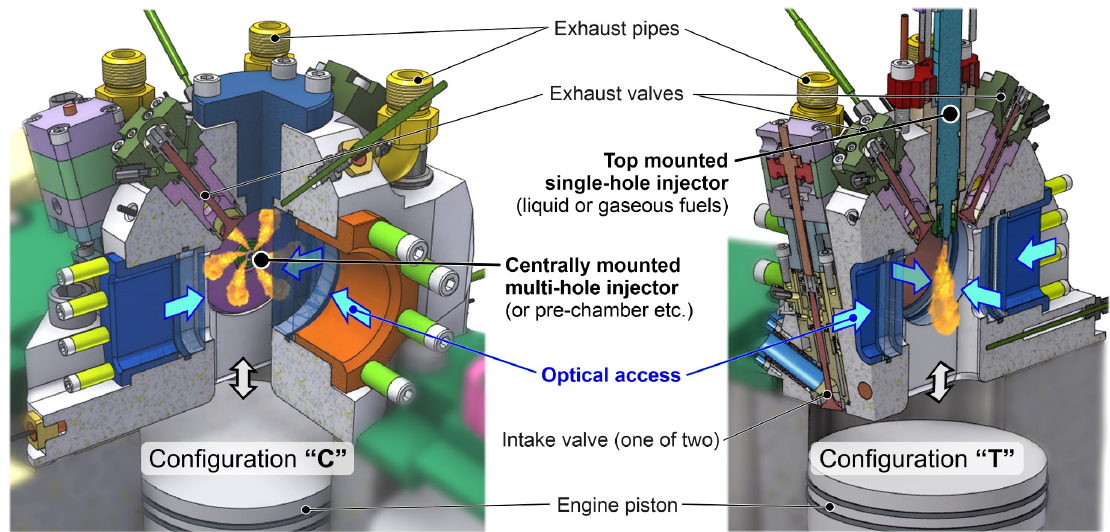
Figure 7. The two basic configurations of the test rig: (left) the setup with a central multi-hole injector / prechamber / ignition source mounted in place of one of the circular windows (configuration “C”); and (right) the configuration with the injection / prechamber / ignition source mounted on top of the cylinder head. This configuration provides “see through” optical access from two directions and maximizes the observable fuel spray / gas-jet length.